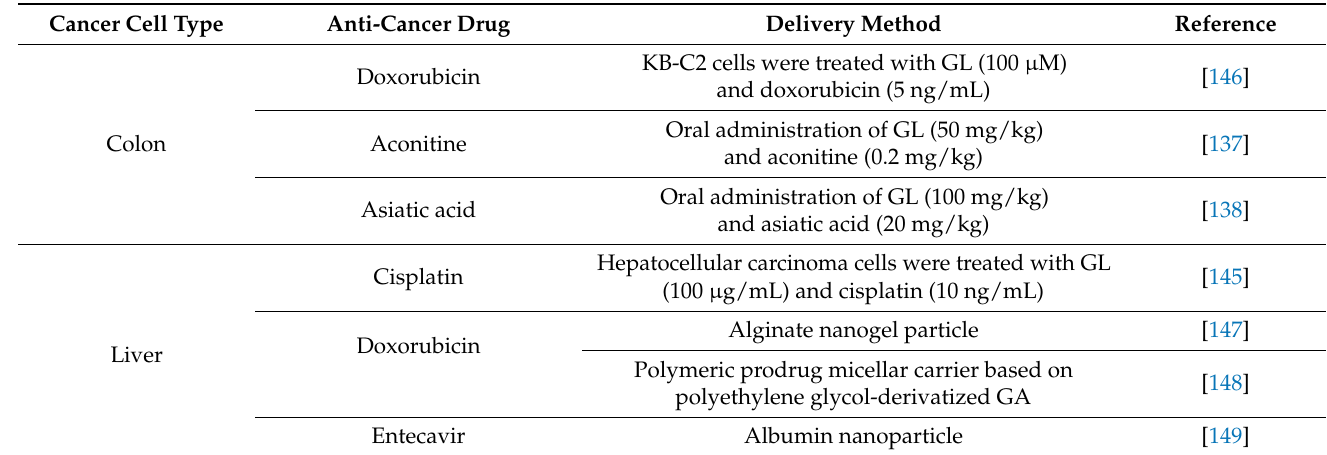
Table 5. Co-delivery of GL and anti-cancer